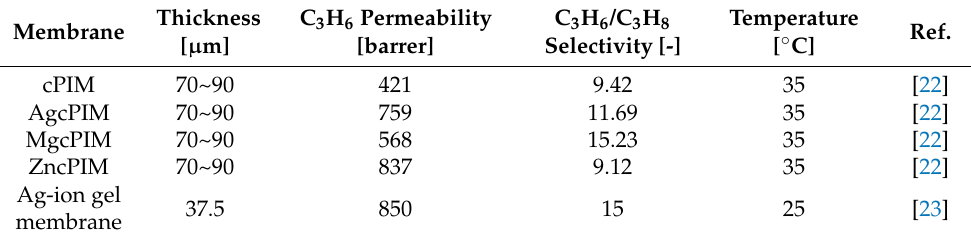
Table 3. Separation performance of C 3 H 6 /C 3 H 8 for facilitated transport membranes.